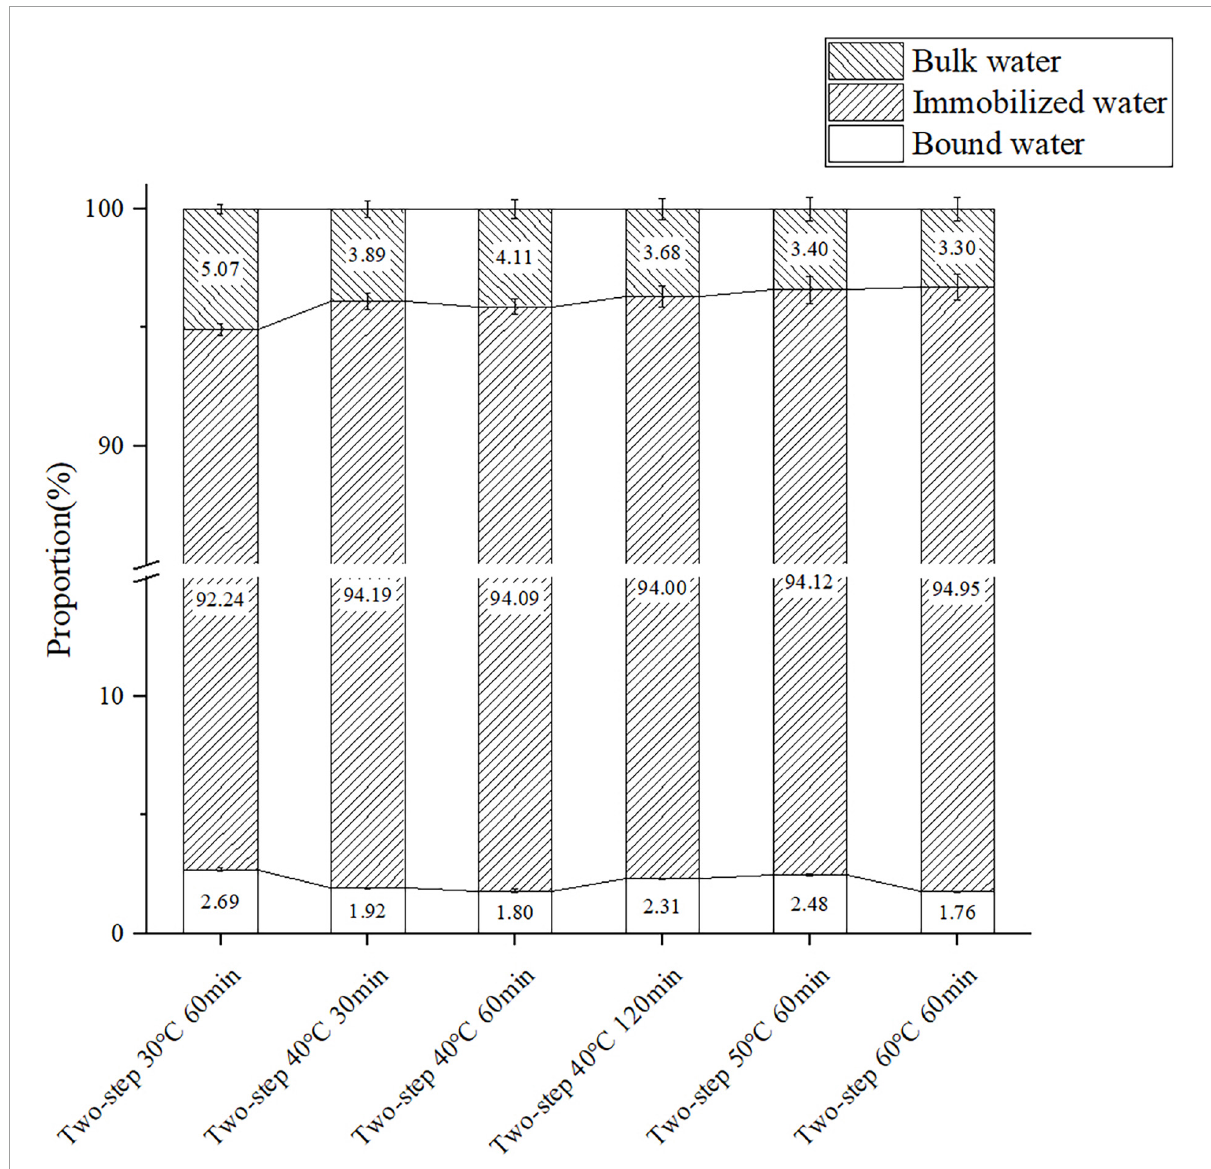
FIGURE7 The content of the three components of surimi gels formed under different gel softening degree. Data were obtained as the mean ± standard deviation ( n =